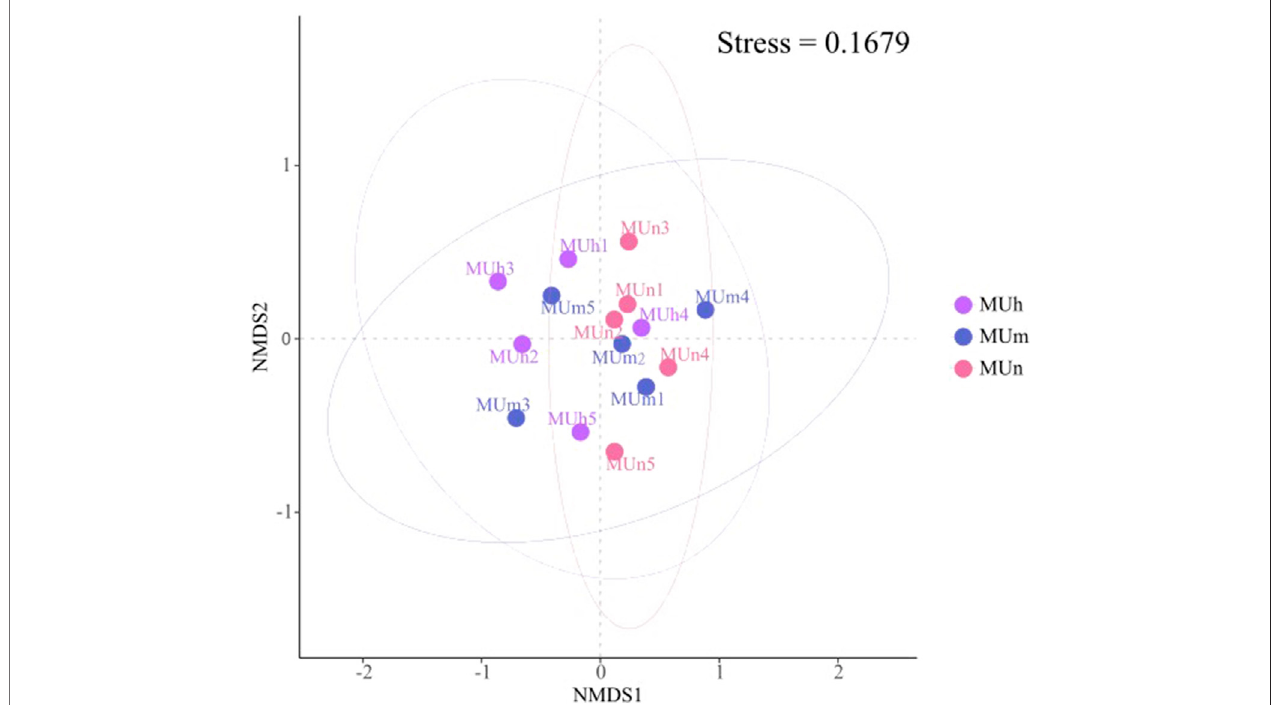
FIGURE3| NMDS ordination oftheEcMfungalcommunityassociatedwith P.sylvestris atdifferentage groups,Stress=0.1679.Each pointrepresentsadifferent sample ( fi ve samples from each age group). The con fi dence ellipse represents the con fi dence region in different age plots ( α = 0.05).